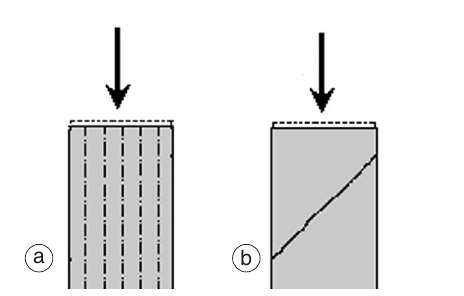
Fig 8a,b. Fracture modes of geomaterials: a) planes parallel to the direction of stress, b) planes di- agonal to the direction of